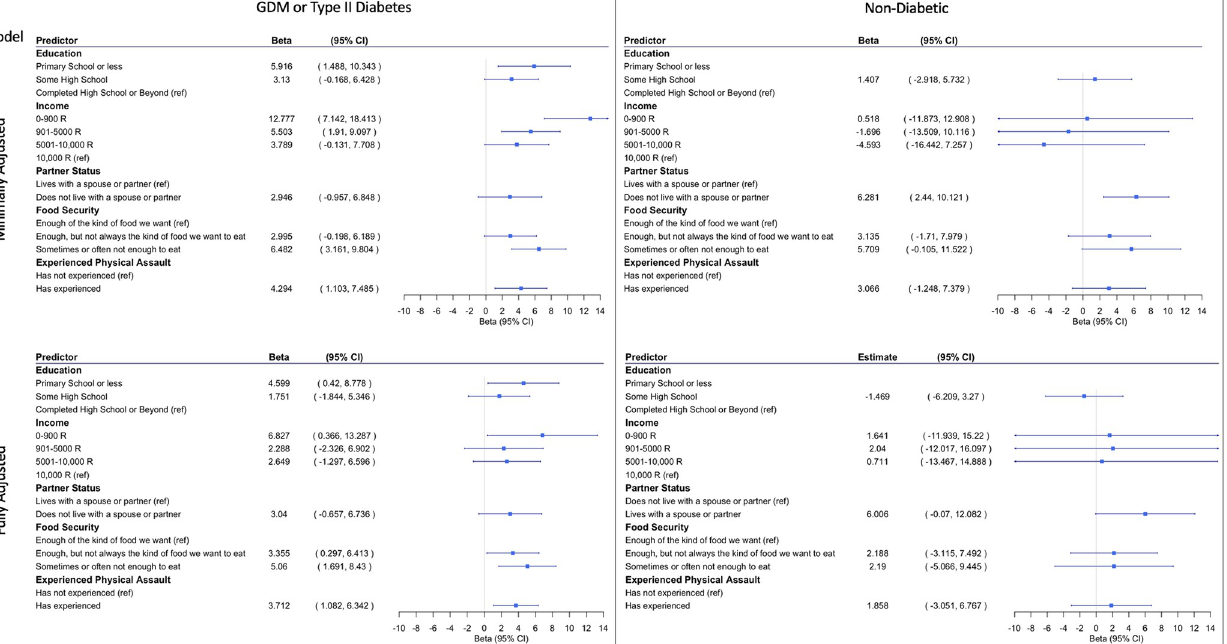
PLOS Global PublicHealth | https://doi.org/10.1371/journal.pgph.0001124 October 5,